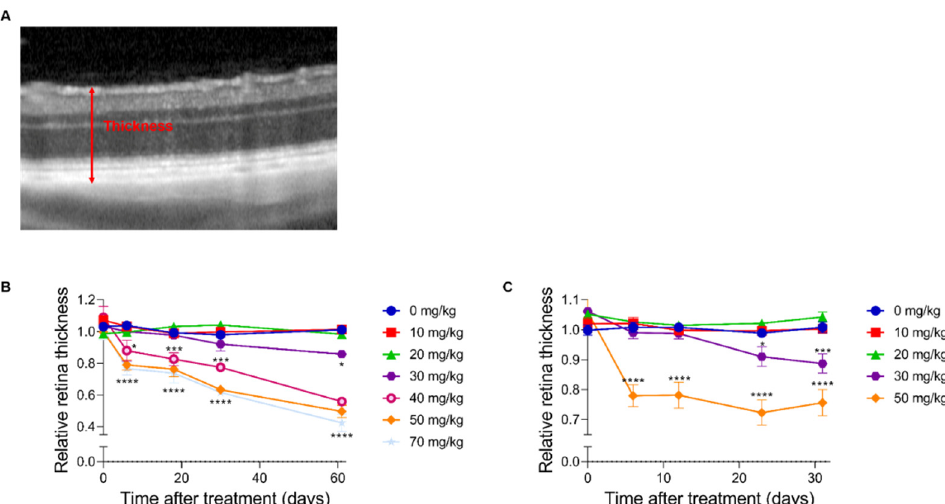
Figure 3. A quantitative analysis of the full retina thickness. The degeneration after SI injection was quantified in C57BL/6J mice ( B ) and Brown Norway rats ( C ) using the full thickness of the retina (red arrow) ( A ) ( n = 4 per group). No significant effects were observed in both species for the 10 and 20 mg/kg treatment group compared to the control group (0 mg/kg). At two months post-injection, a thickness of ±90% of its original thickness was observed in the 30 mg/kg treatment group. More dramatic effects were observed in the higher treatment groups (40, 50, and 70 mg/kg). The degeneration started to show within a week post-injection. A relative thickness of 40–60% was observed two months post-injection. The results are presented as the mean ± the standard deviation. *: p ≤ 0.05, ***: p ≤ 0.001 and ****: p ≤ 0.0001.